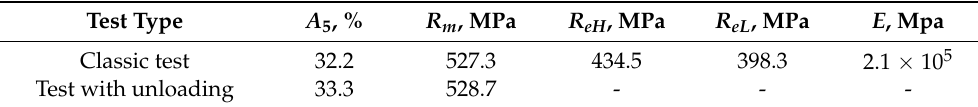
Table 2. Static test results.